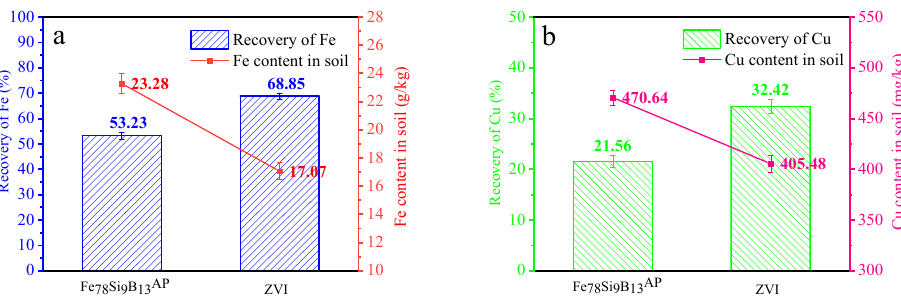
Figure 5. The recovery of Fe ( a ) and Cu ( b ) from soil by magnetic separation after Fe 78 Si 9 B 13AP and ZVI treatment (initial Cu in soil = 600 mg/kg, soil/solution = 1 g/10 mL, stabilizers dosage = 50 g/kg, T = 323 K).